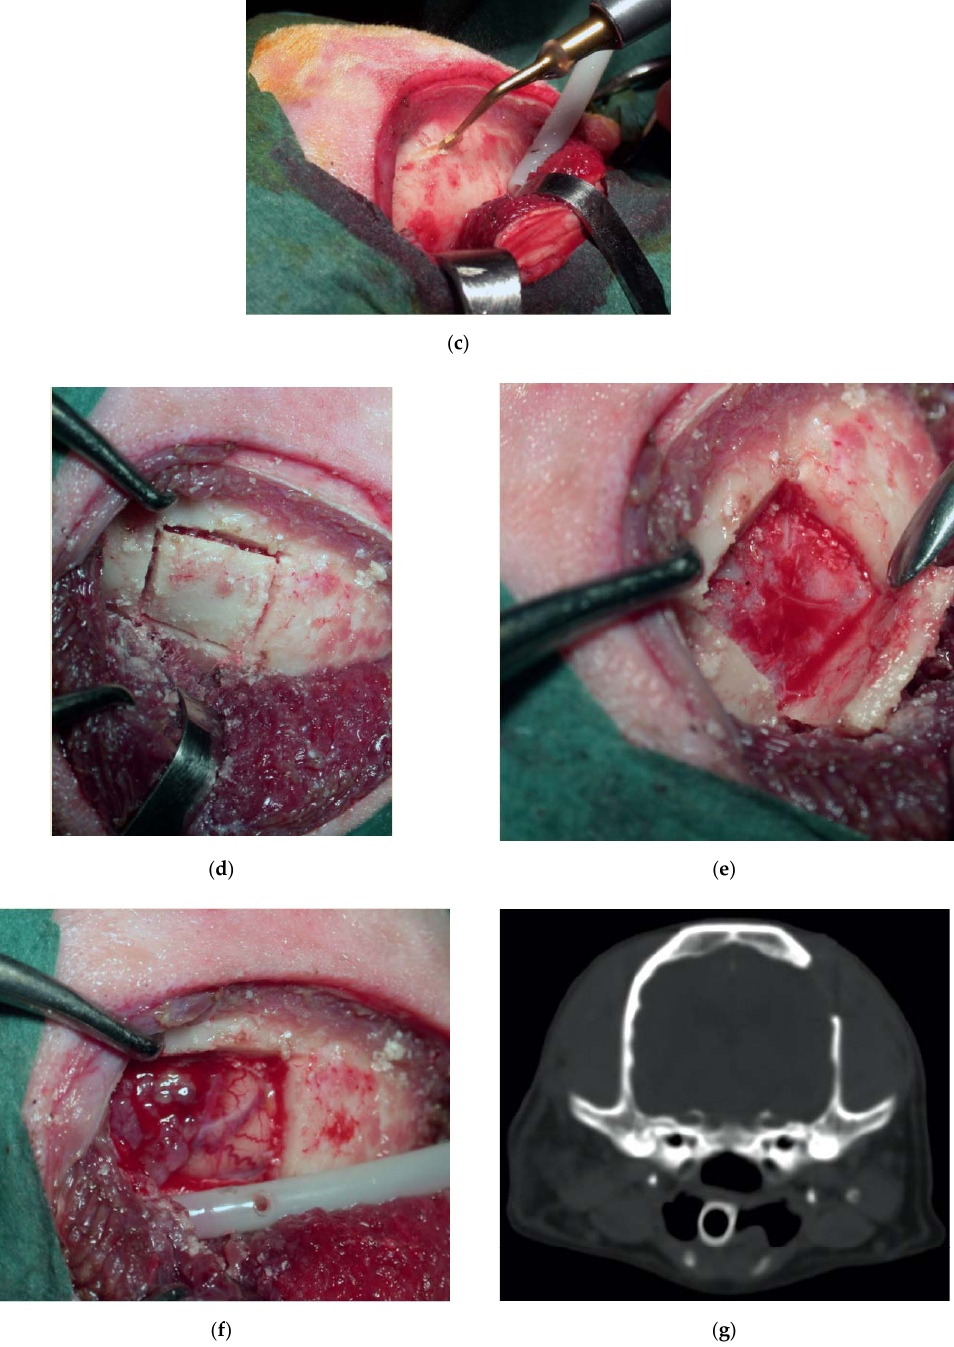
Figure 6. Preoperative contrast ‐ enhanced CT scan, showing a suspected left parietal meningioma ( a ). Intraoperative pictures showing the initial steps of the craniotomy ( b ). The bone flap was cut with piezoelectric scalpel and an angled large saw tip (OT7, Osteotomy Tips Kit, Mectron Medical Technology, Genoa, Italy) ( c , d ). The dura was completely preserved ( e ). En bloc removal of meningioma ( f ). Postoperative CT scan performed at six ‐ month follow ‐ up, showing the sharpness of the edges of the craniotomy. No osteosclerosis or bony resorption was evident ( g ).